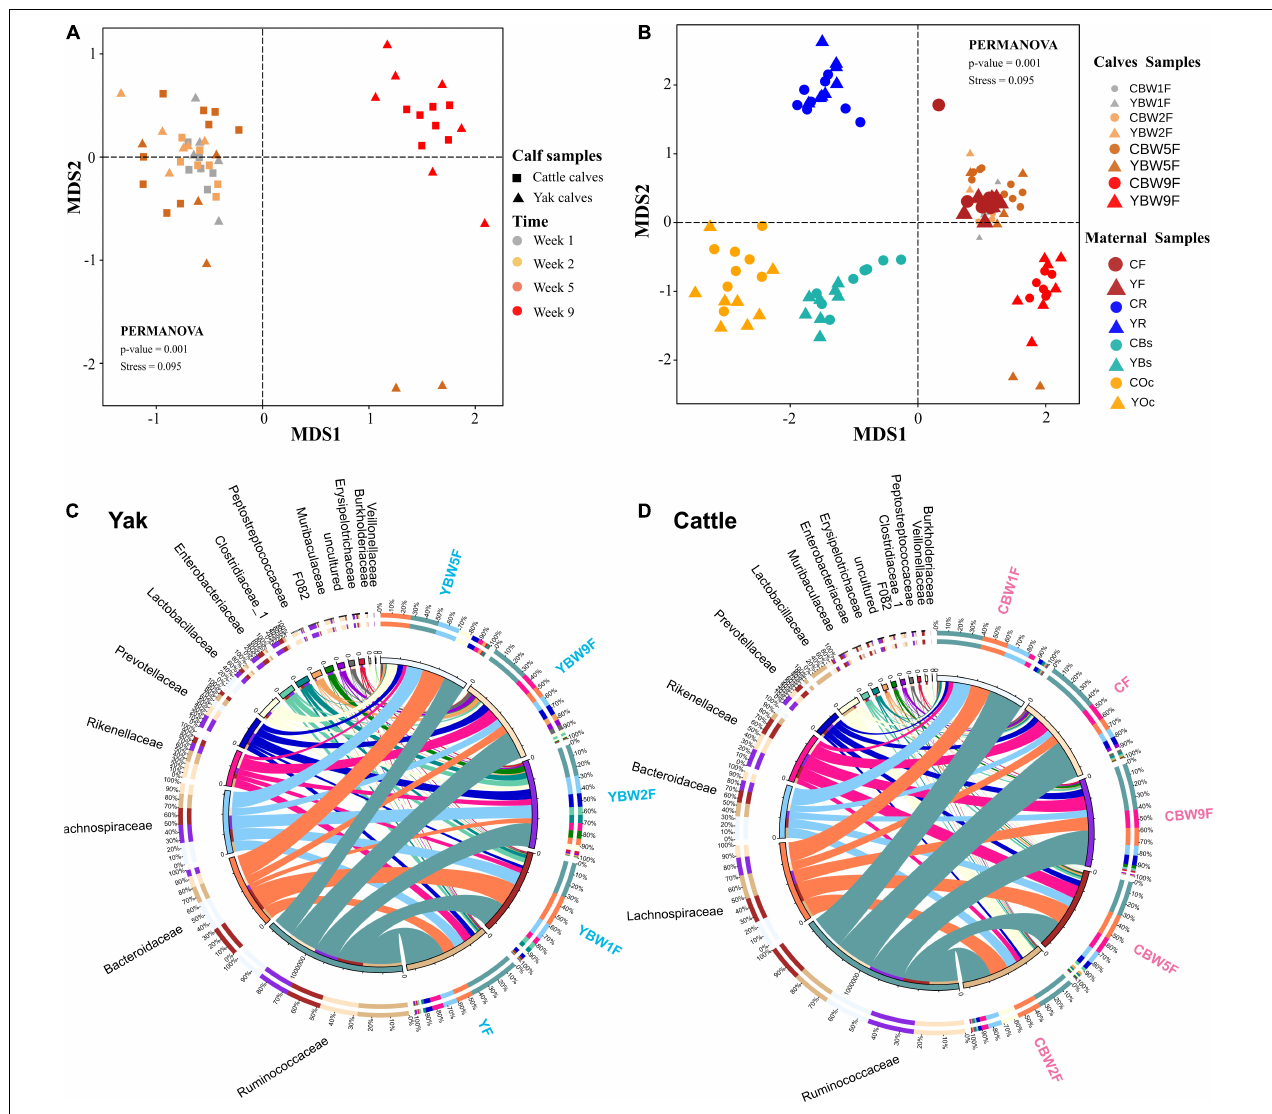
FIGURE 3 | Diversity and composition of microbial communities in calf and maternal samples. (A) NMDS plot based on Bray–Curtis distance shows the differences between yak and cattle calves in different weeks after birth, and the differences between groups were analyzed by PERMANOVA. (B) NMDS plot based on Bray–Curtis distance shows the differences between calves and their mothers’ samples at different time points. A greater distance between two points infers a lower similarity, whereas similar ASVs cluster together. YR, YF, YBs, and YOc represent rumen fluid, feces, breast skin, and oral cavity samples from yak at 1 week post parturition; CR, CF, CBs, and COc represent rumen fluid, feces, breast skin, and oral cavity samples from cattle at 1 week post parturition. Circos diagram shows the composition of fecal microbiota at the family level (top 15) of yak (C) and cattle calves (D) in different weeks after birth, respectively. The length of the bars on the outer ring and the numbers on the inner ring represent the percentage of relative abundance of genera detected in each sample and the number of sequences in each sample, respectively. The bands with different colors show the source of each sequence affiliated with different